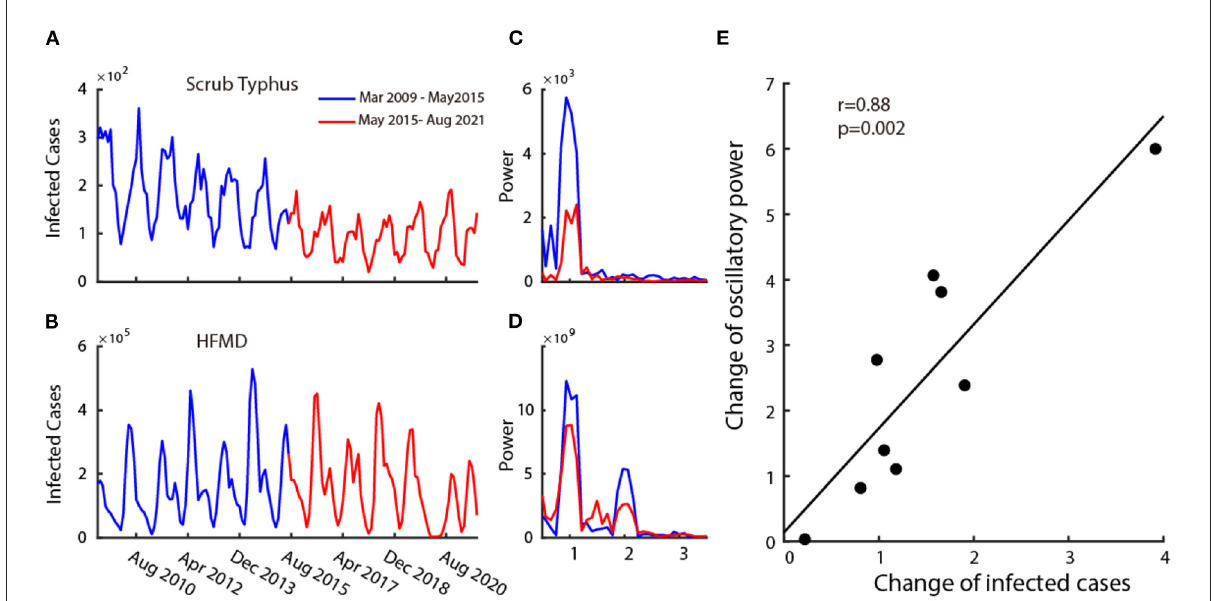
FIGURE3 Relationship between the infection and its oscillatory strength. Plot (A,B) are two examples of disease’s time series monthly infected cases from 2009 to 2021. The blue curve shows the time series of the first 6 years (2009–2015) and the red curve shows the time series of the last 6 years (2015–2021). Plot (C,D) show the power spectrum calculated in the first 6 years (blue curve) and the last 6 years (red curve) corresponding to the time-series data of (A,B) . Plot (E) shows the scatter plot of change in mean infected cases and change in oscillatory